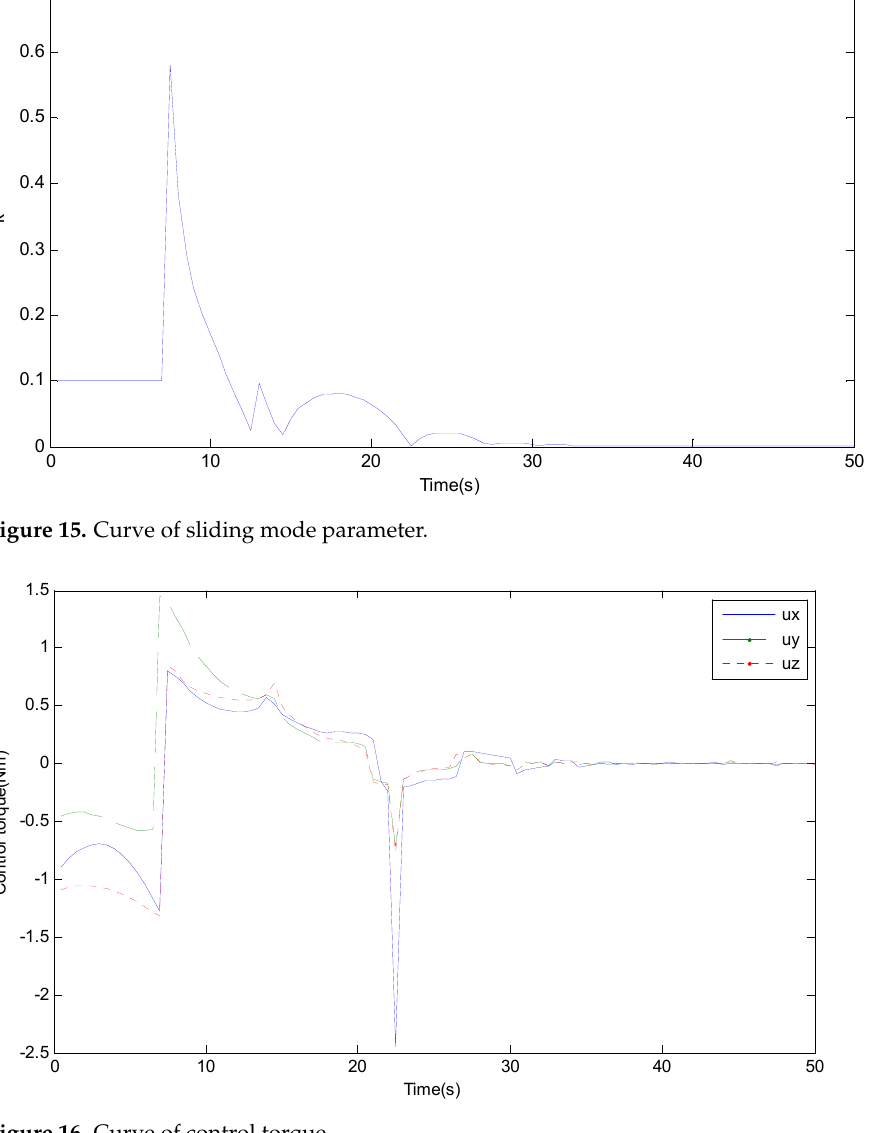
Figure 16. Curve of control torque.